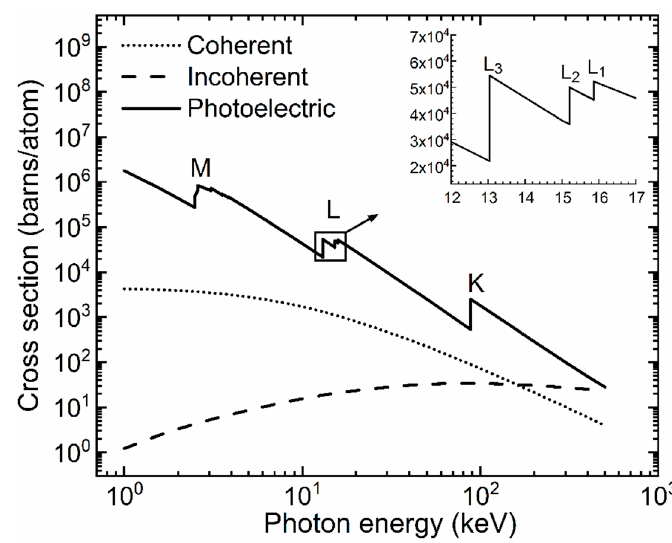
Figure 2. Plot of the X-ray photon coherent, incoherent (Compton), and photoelectric cross sections of Pb in the 1 keV to 500 keV energy range. The main log–log plot indicates the strong dependence of these interactions on the photon energies. The sub-plot shows the edges of the three L sub-shells. The upper-case letters in the main plot indicate the edges corresponding to the K-, L-, and M-shells. In the quantum mechanical theory of the atom, these shells are identified by the principal quantum number n values of 1, 2, and 3, respectively.